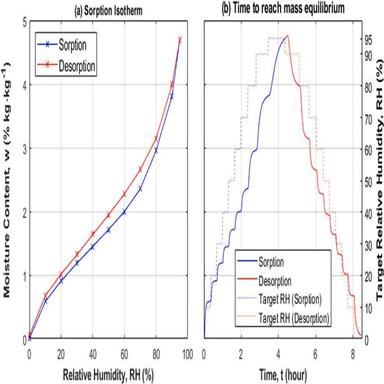
(a) Sorption-desorption curves with Moisture Content w plotted against RH and (b) time to reach mass equilibrium under dw/dt = 0.01 for the aerogel composite.